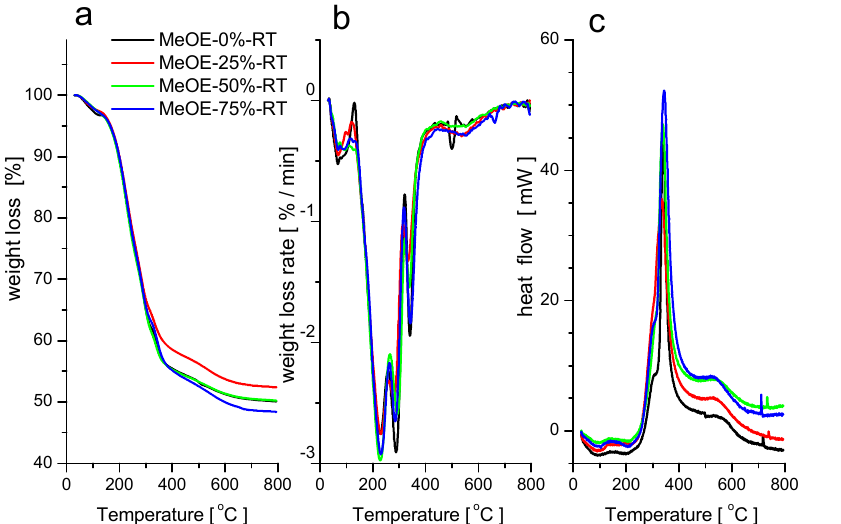
Figure 2. TG ( a ), DTG ( b ) and DSC ( c ) curves for samples prepared at room temperature.